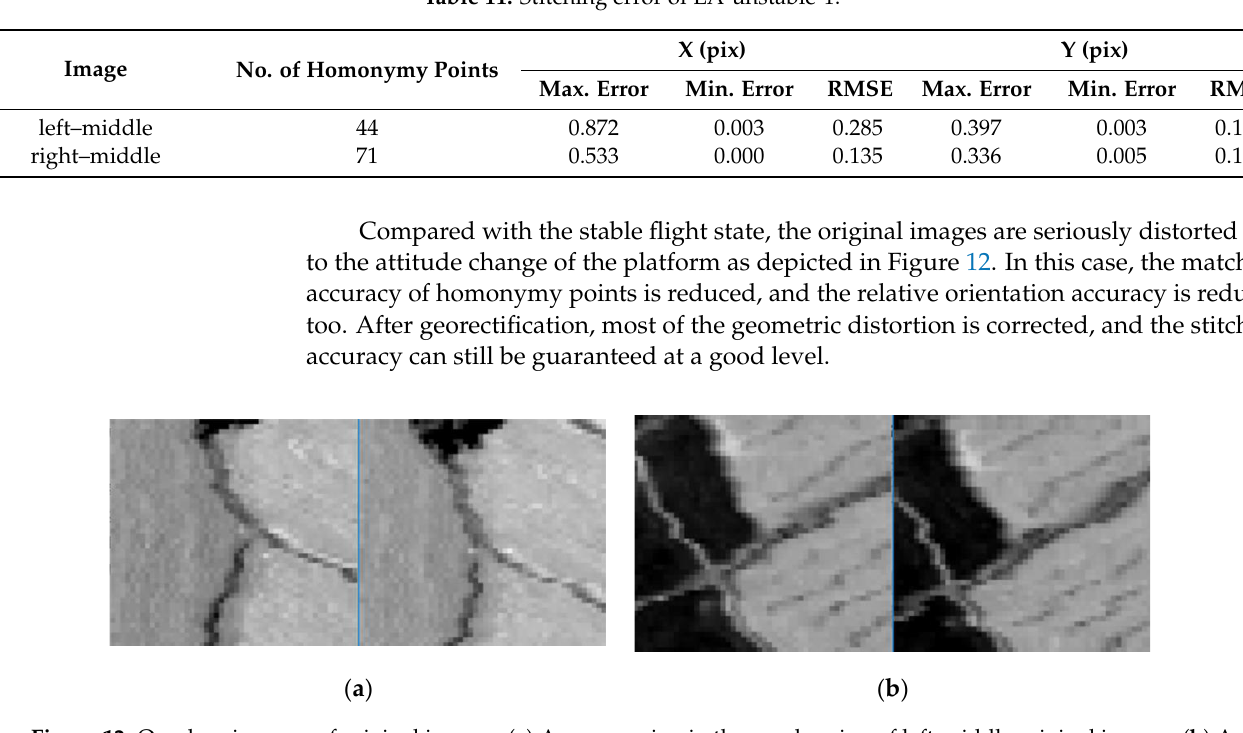
Figure 12. Overlapping area of original images: ( a ) A same region in the overlapping of left-middle original images; ( b ) A same region in the overlapping of right-middle images.